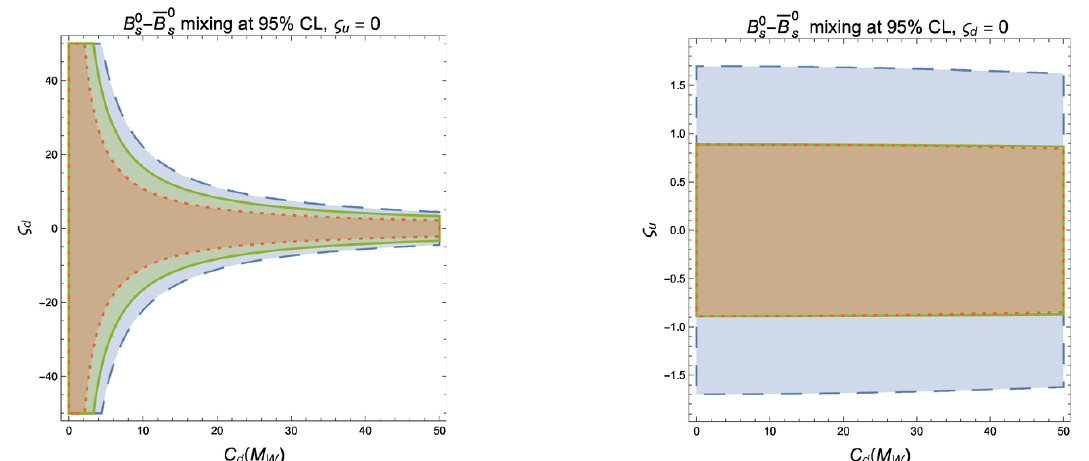
- (cid:22) B 0 mixing constraints on C d ( M W ) and & d ( & u ) for s s